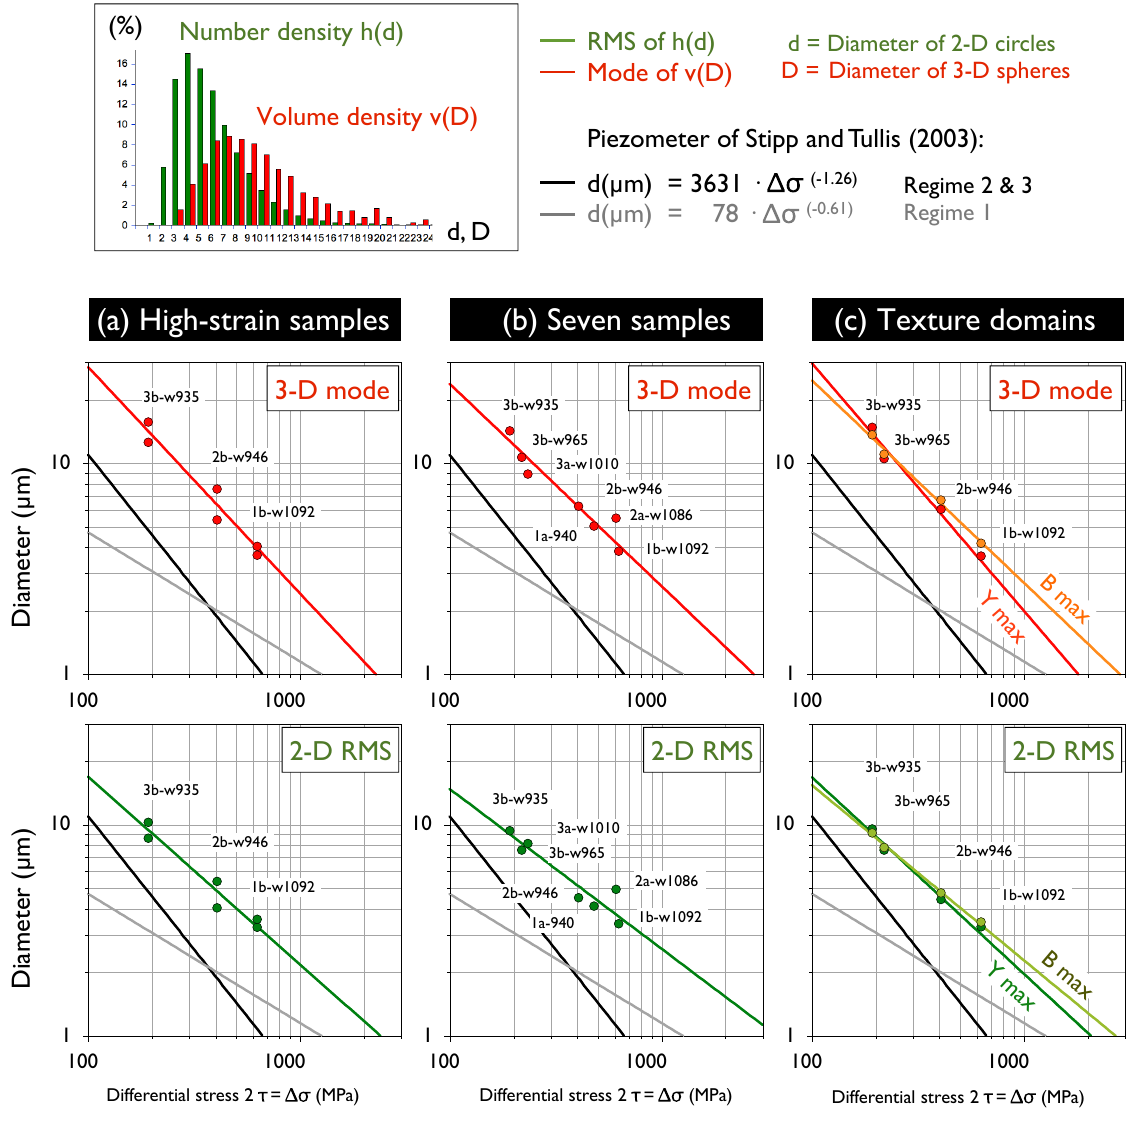
Figure 10. Recrystallized grain size as a function of flow stress. Two measures of average grain size are plotted against differential stress, (cid:49)σ (with (cid:49)σ = 2 τ ; see Table 1). Top row: mode of v(D) where D = diameter of volume equivalent sphere and v = volume weighted frequency distribution ( = 3-D mode). Bottom row: root mean square of h(d) where d = diameter of area equivalent circle and h = frequency distribution as used for the piezometer relation by Stipp and Tullis (2003) ( = 2-D RMS). Separate plots are shown (a) for three high-strain experiments (5 . 8 < γ < 7 . 1) with the higher value deriving from the low-gKAM region and the lower value from the high-gKAM region (see Fig. 6) (b) for the bulk measurement of each of the seven experiments (see Table 1) and (c) for the grain sizes of the Y and B domains (see Table 2). The piezometer curves for regimes 2 and 3 (black) and for regime 1 (gray) of Stipp and Tullis (2003) are always included for